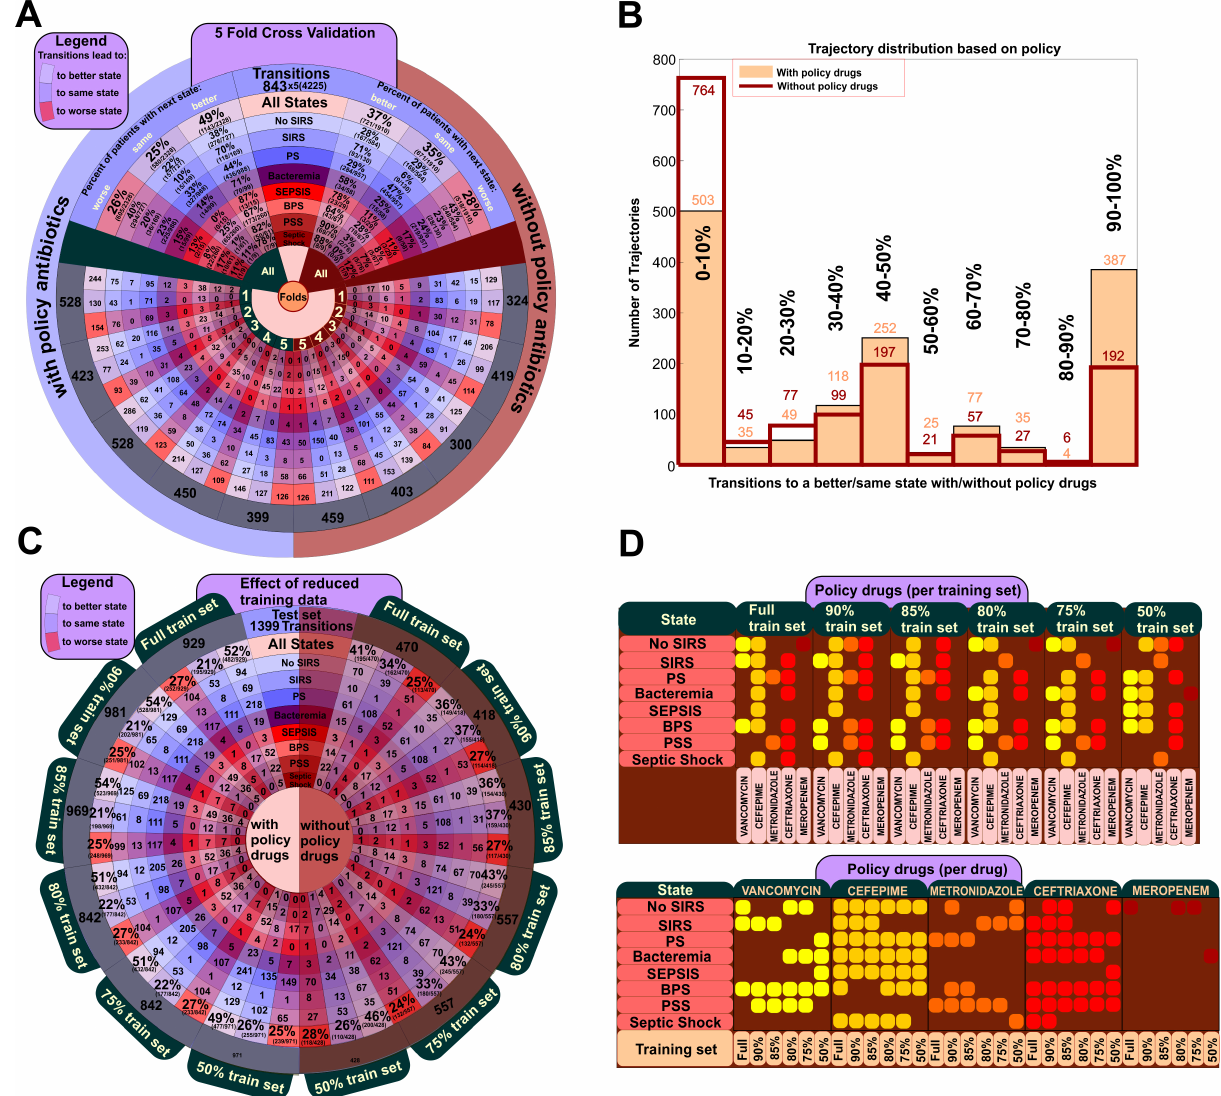
Figure 6. Performance and Robustness of the POMDP Clinical Decision Support System for Sepsis. (A) 5-fold cross-validation results depict the performance of each fold with (left, blue) and without (right, brown) using the policy-proposed antibiotic combination. Each cell contains the number of transitions (4225 total transitions; 843 transitions per test fold) that lead to worse, equal or better states in each case. A state-specific percentage across all folds allows for comparison between the different policy strategies. (B) Number of patient trajectories vs. the percentage of their transitions that lead to a better state. (C) Dependency of CDSS performance on data size based on stratified reduction of the dataset. Outcome is shown for policy-proposed antibiotic combinations (left) and all other combinations (right) for different states (D) Changes in antibiotic combinations proposed in calculated optimal policy as a function of data-size reduction. Each row is a state and each column represents a drug-training set combination. The two tables depict which drug combinations were found to lead to better outcomes when in the perspective state, in the general case. States are as defined in the Methods sections, with three states denoting uncertainty due to missing data (PS: probable sepsis; BPS: bacteremia, probable sepsis; PSS: probable septic